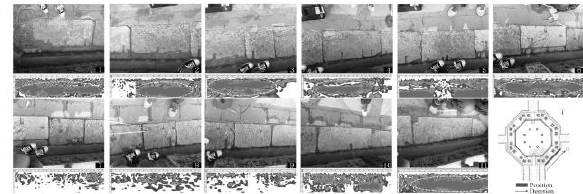
Figure. 8. Picture of southeast rectangular stones ultrasonic test.